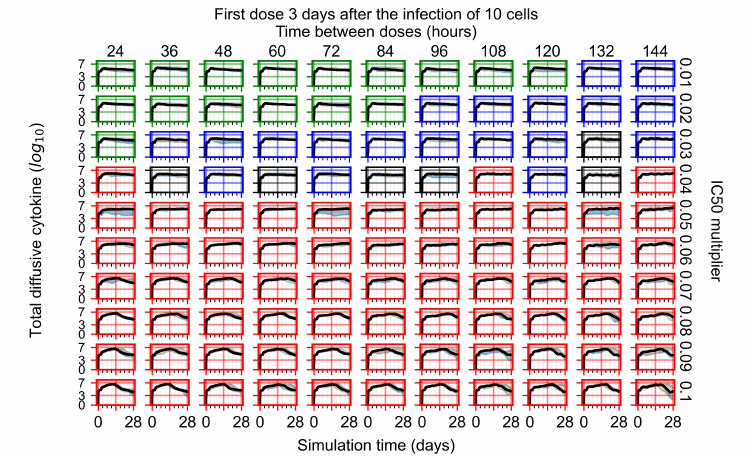
Figure A105. Total diffusive virus produced (AUC), Y axis in log scale, and exponent values as tick marks.